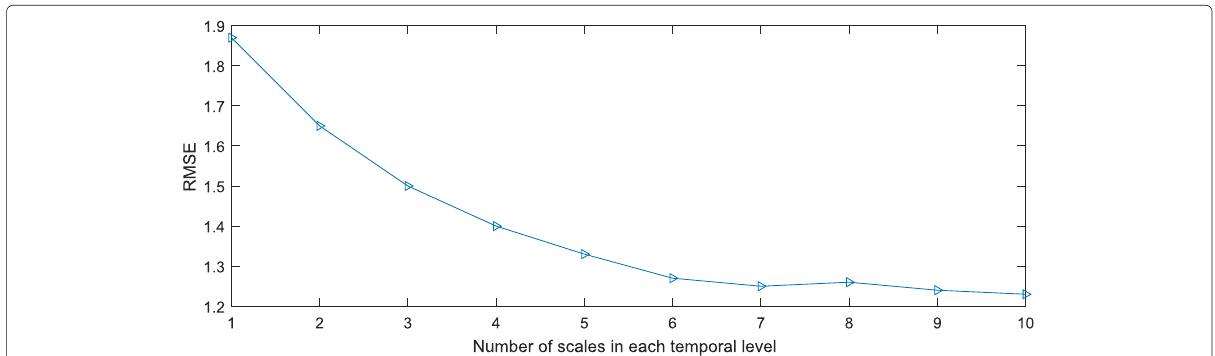
Fig. 7 RMES as a function of number of